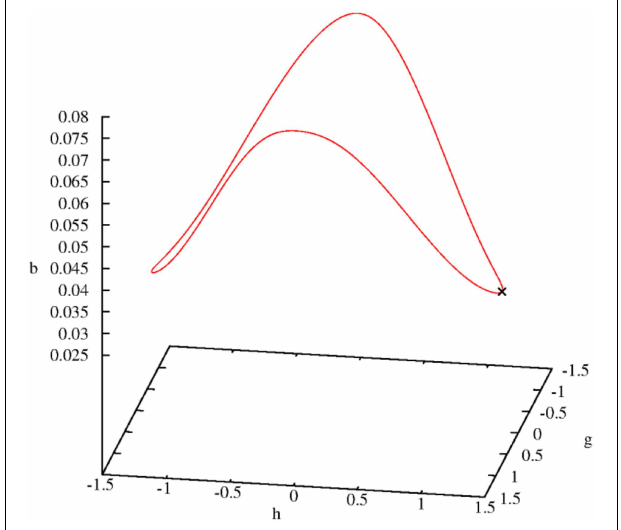
FIGURE 3 | Three-dimensional limit cycle defined by the three variables b , g, and h . The initial point is marked by a